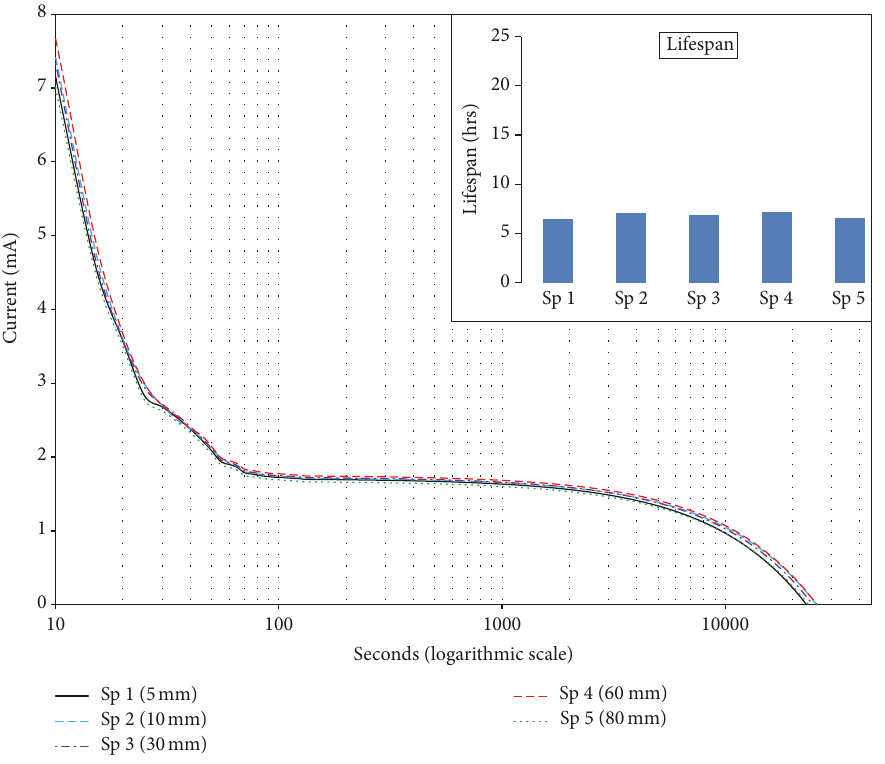
Figure 12: Current discharge curves across a 10 Ω resistor for increasing electrode spacing.